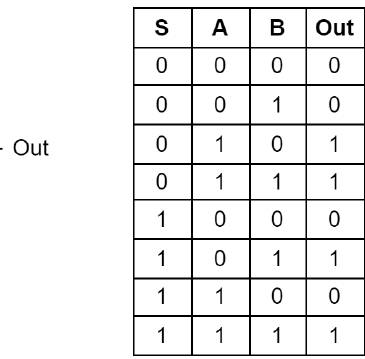
Figure 3. The 2-to-1 MUX and its truth